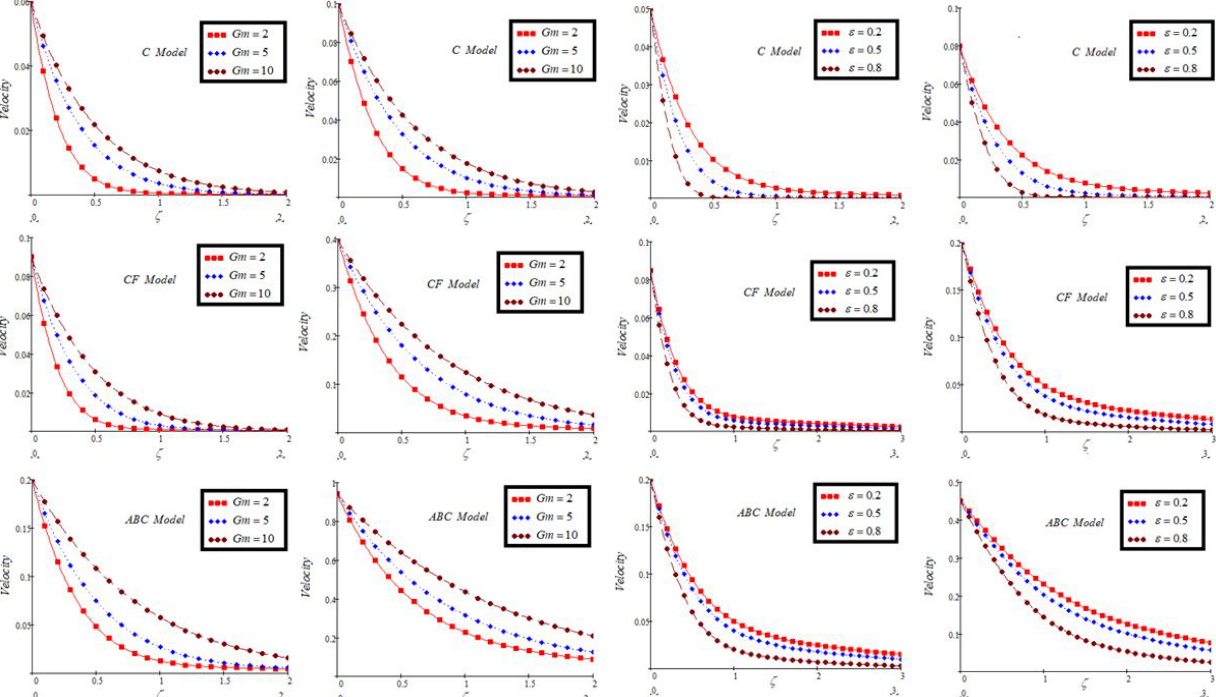
Figure 8: Velocity profile for FD’s with variation of ε and Gr =